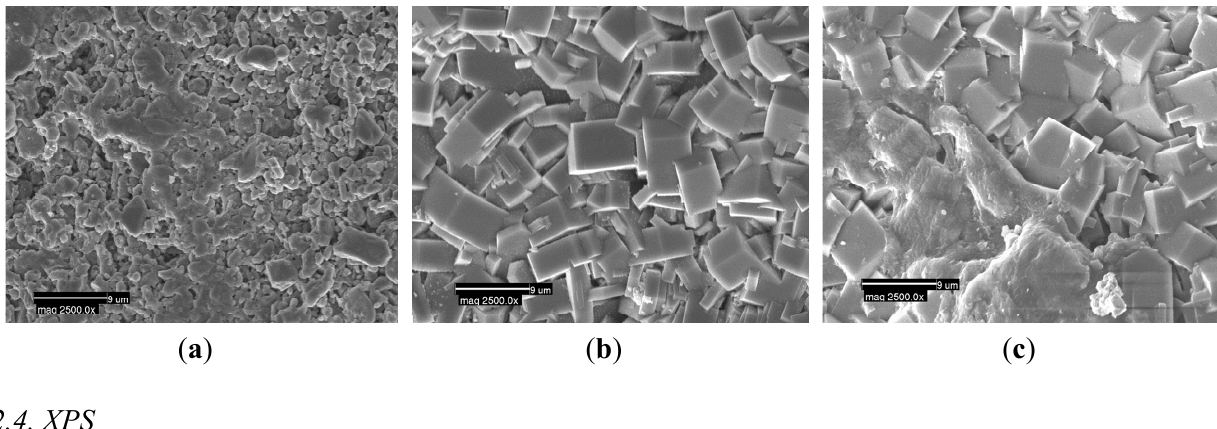
O substrate; ( b ) original zeolite 2 3